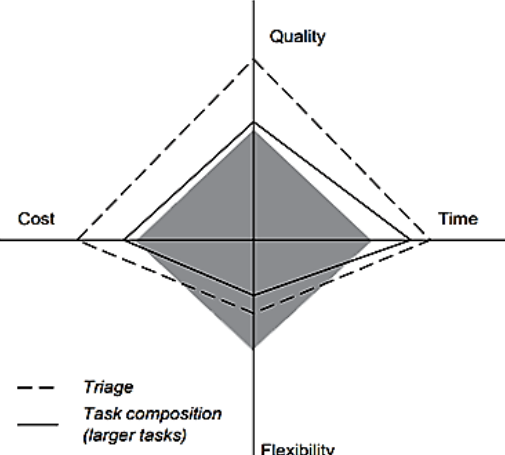
Figure 3. Devil’s quadrangle for the selected BP behavior heuristics.